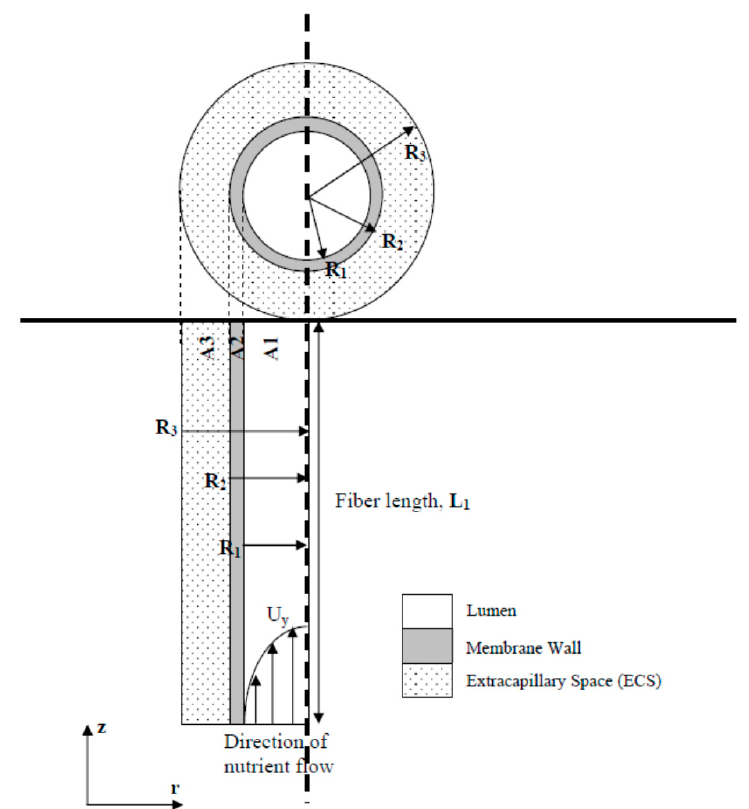
Figure 1. Schematic diagram of a hollow fibre membrane bioreactor (HFMB). Three domains are defined, namely, A1—fibre lumen, A2—membrane wall, and A3—extracapillary space (ECS). Please refer to Table 2 for the dimensions of the respective sections and other key parameters. The figure is reproduced from [5] with copyright permission.